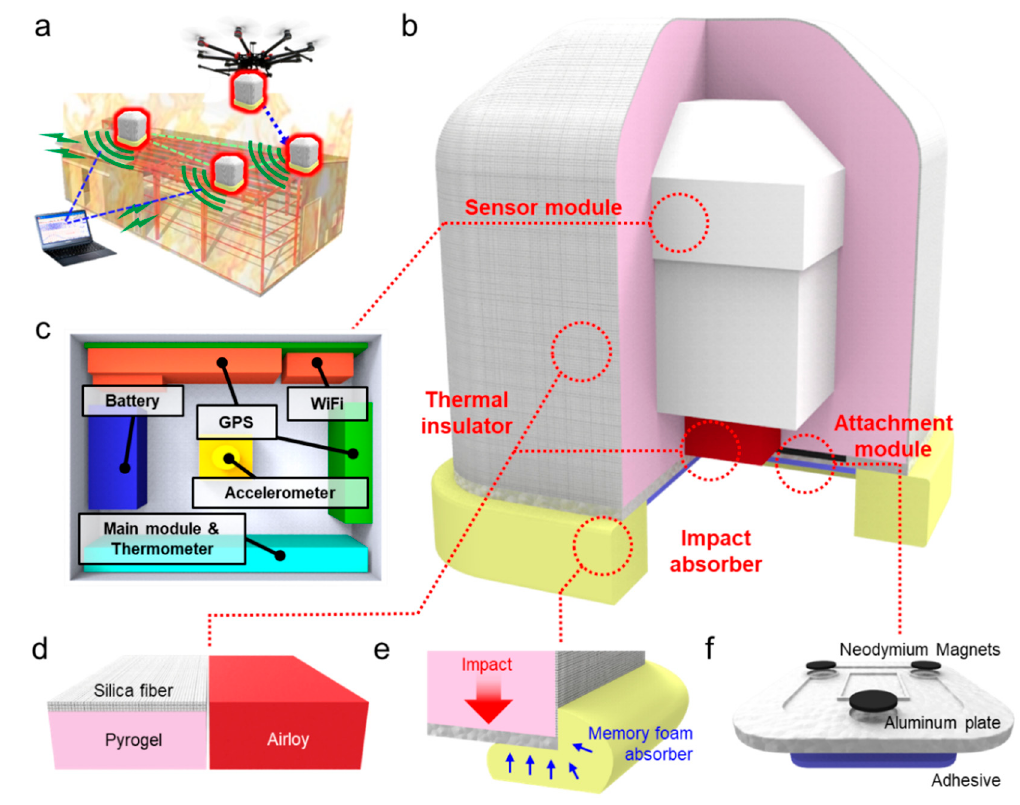
Figure 1. Conceptual drawing of remotely deployable smart sensor device for structural health monitoring system of pre-engineered building (PEB) structure in a fire situation. ( a ) Schematic of the smart ball sensor in a fire situation; ( b ) illustration of the smart ball sensor consisting of various module; ( c ) schematic of sensor module, ( d ) thermal insulator, ( e ) impact absorber and ( f ) attachment module.